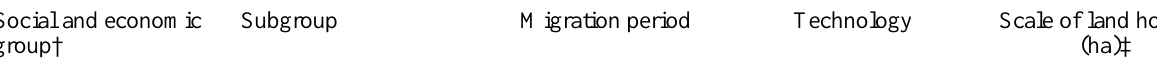
Table 1. Criteria used to recognize and spatially define 10 social and economic actors, as well as the extent of restricted use and urban